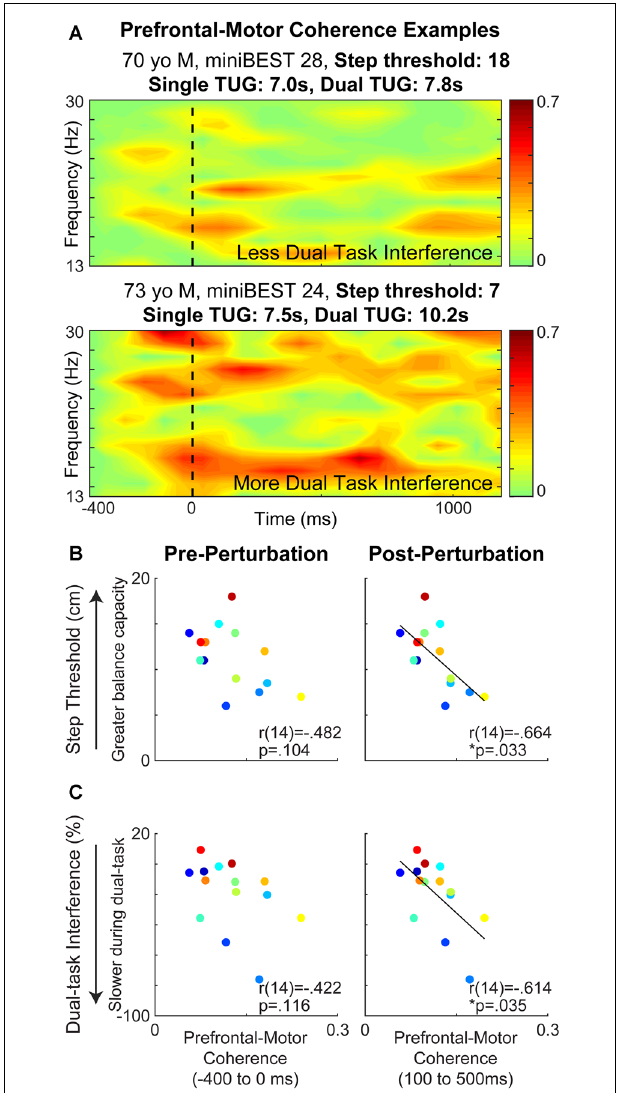
FIGURE 5 | Prefrontal-motor cortical beta coherence during balance reactions and relationships to balance behavior. Prefrontal-motor beta coherence was different between individuals with less vs. more cognitive dual-task interference. The broken line indicates the onset of perturbation (A) . Prefrontal-motor coherence was negatively associated with reactive step threshold ( p = 0.033) (B) and cognitive dual-task interference ( p = 0.035) (C) at post-perturbation but not pre-perturbation